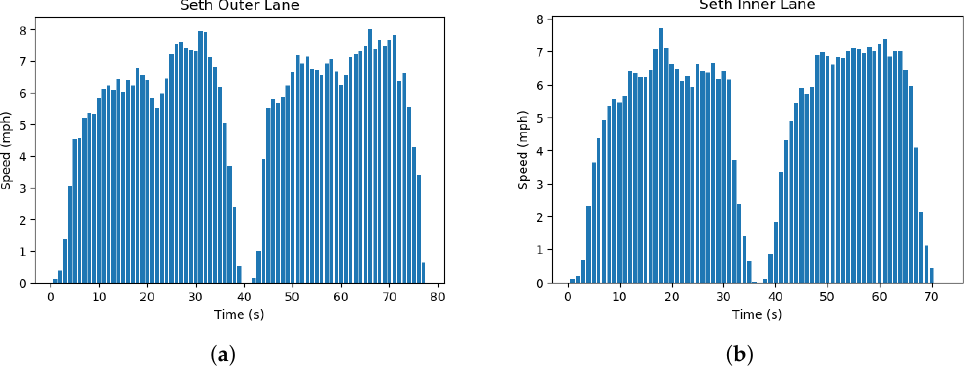
Figure A5. Author Seth Rodriguez’s driving graphs for outer and inner